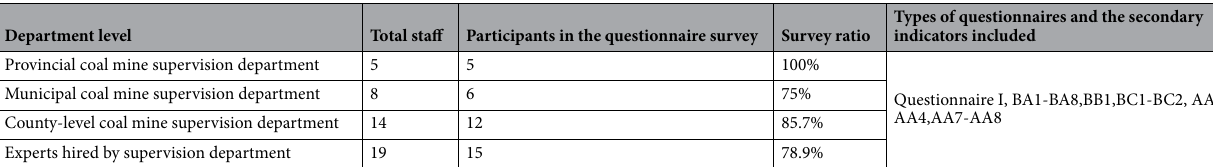
Table 4. Number of participants in questionnaire I.